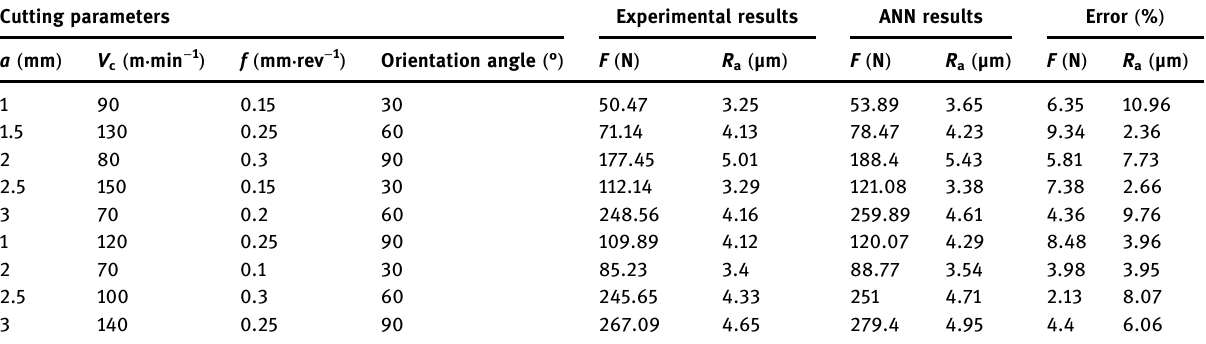
Table 5: Validation results obtained from ANN and experimental study for di ff erent input parameters Cutting parameters Experimental results